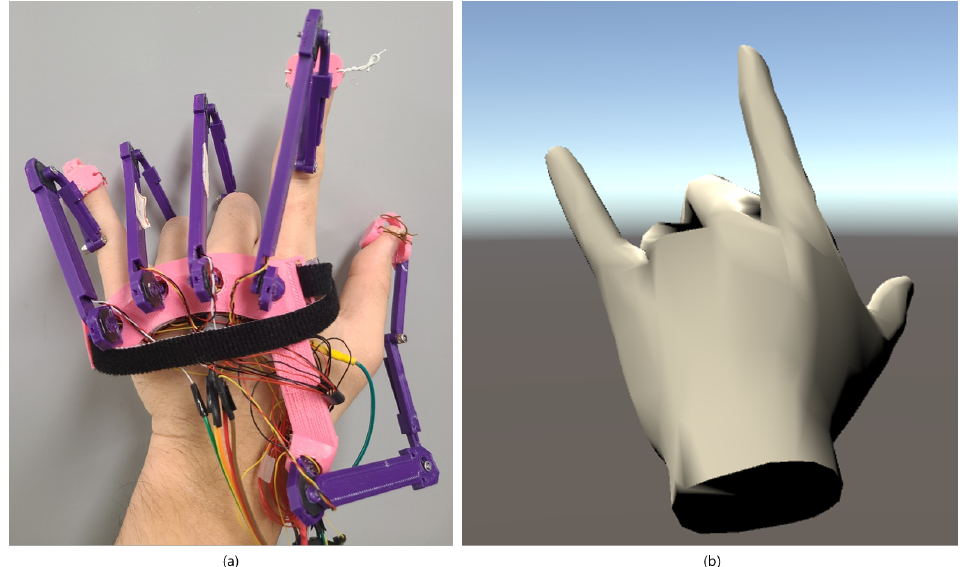
Figure 7. ( a ) Motion in real-world domain; ( b ) modeling result in the virtual-world domain which was done in Unity